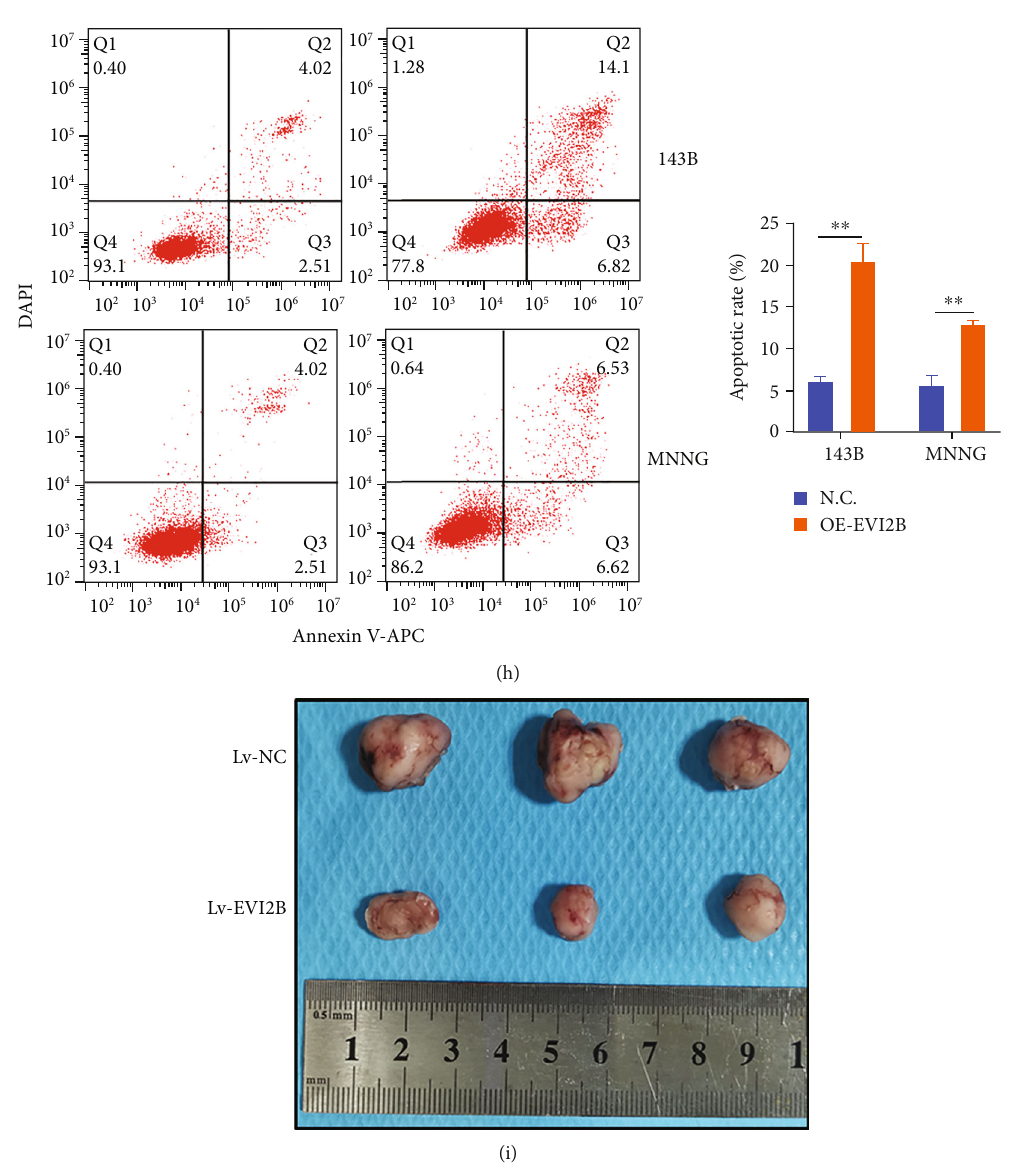
Figure 9: The role of EVI2B in OS. (a – c) Associations between EVI2B levels and survival outcomes in TCGA-OS, GSE21257, and Zhujiang cohorts. (d) KM survival curves for CD4 in the Zhujiang cohort. (e) Correlation between the expression of EVI2B and CD4 in the Zhujiang cohort. (f) The Transwell assay showed that EVI2B overexpression markedly suppressed osteosarcoma cell invasion and migration. (g) The plate colony formation assay was performed to investigate the e ff ects of EVI2B on cell proliferation. (h) E ff ects of EVI2B on apoptosis were evaluated by fl ow cytometry. (i) Images of the subcutaneous